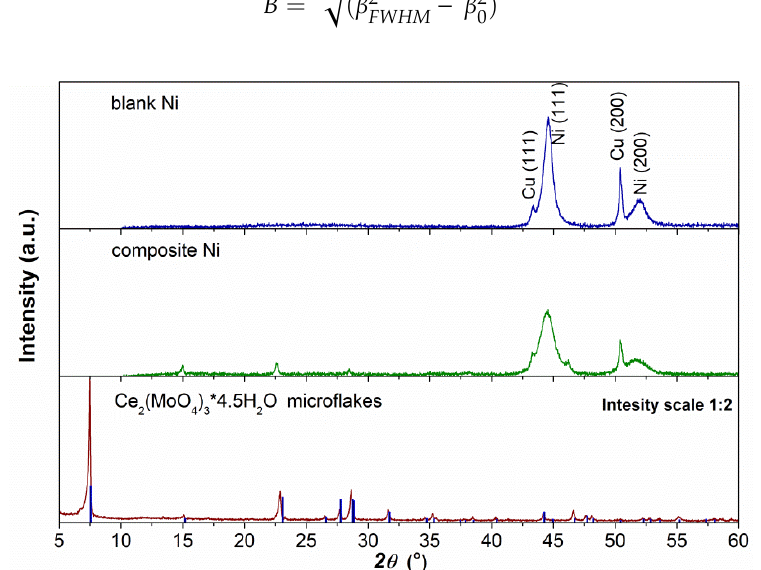
Figure 2. X-ray di ff ractograms for blank and composite Ni coatings deposited on the copper substrate Figure 2. X-ray diffractograms for blank and composite Ni coatings deposited on the copper at a current density of 6 mA cm − 2 at 70 ◦ C for 1 h. A powder di ff raction pattern for